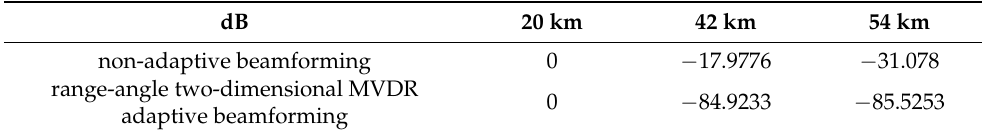
Table 2. Gain comparison table.